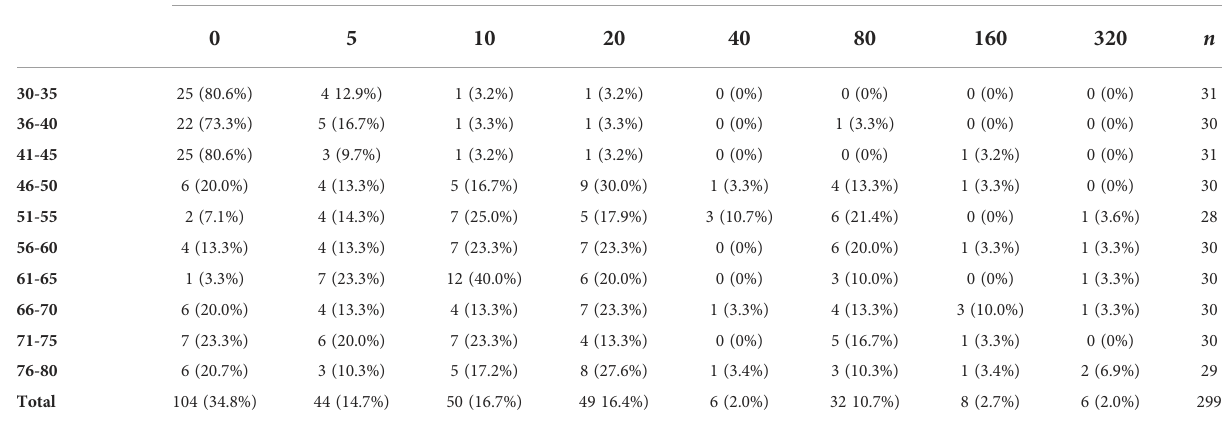
TABLE 2 Virus neutralizing activity for Vaccinia virus in dependence of the age.